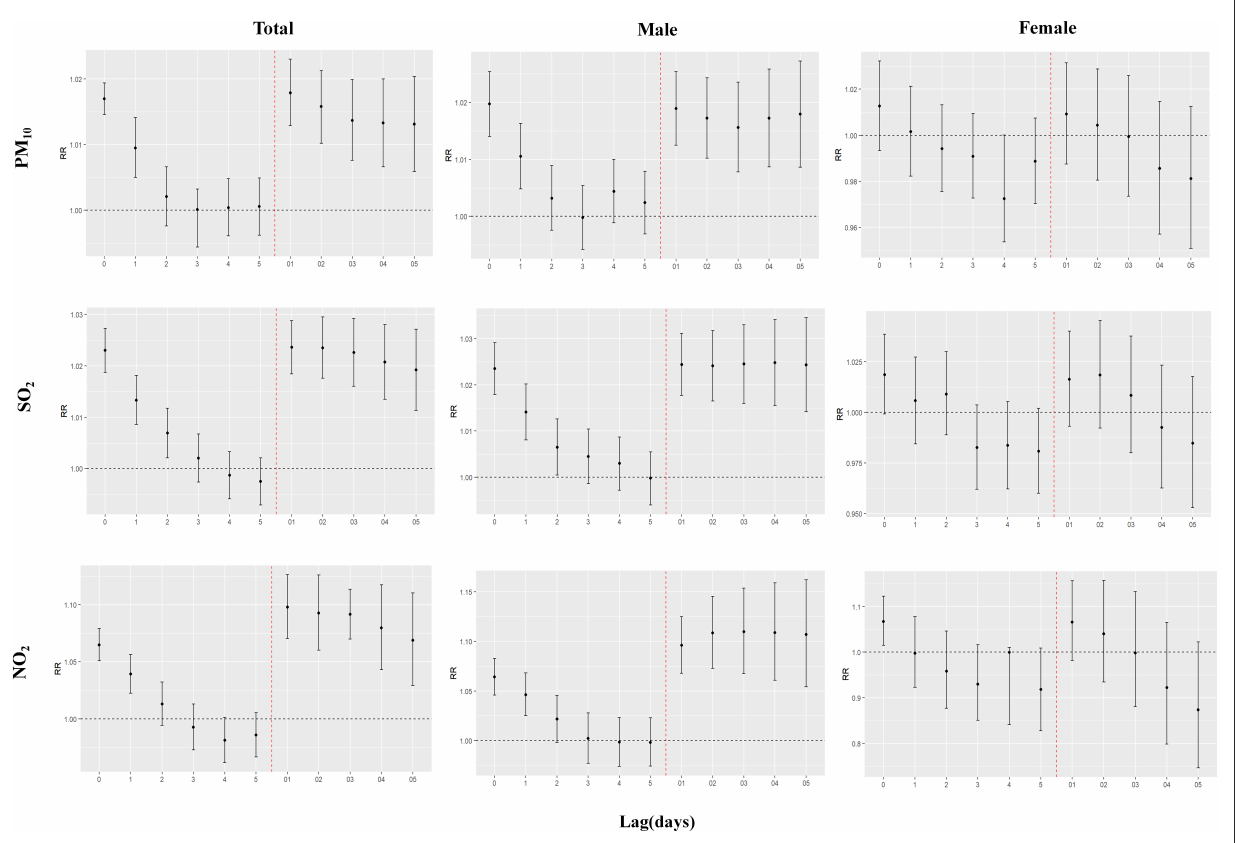
FIGURE2 Overall and sex-specific analyses of appendicitis admissions per 10 µ g/m 3 increase in pollutant concentrations.